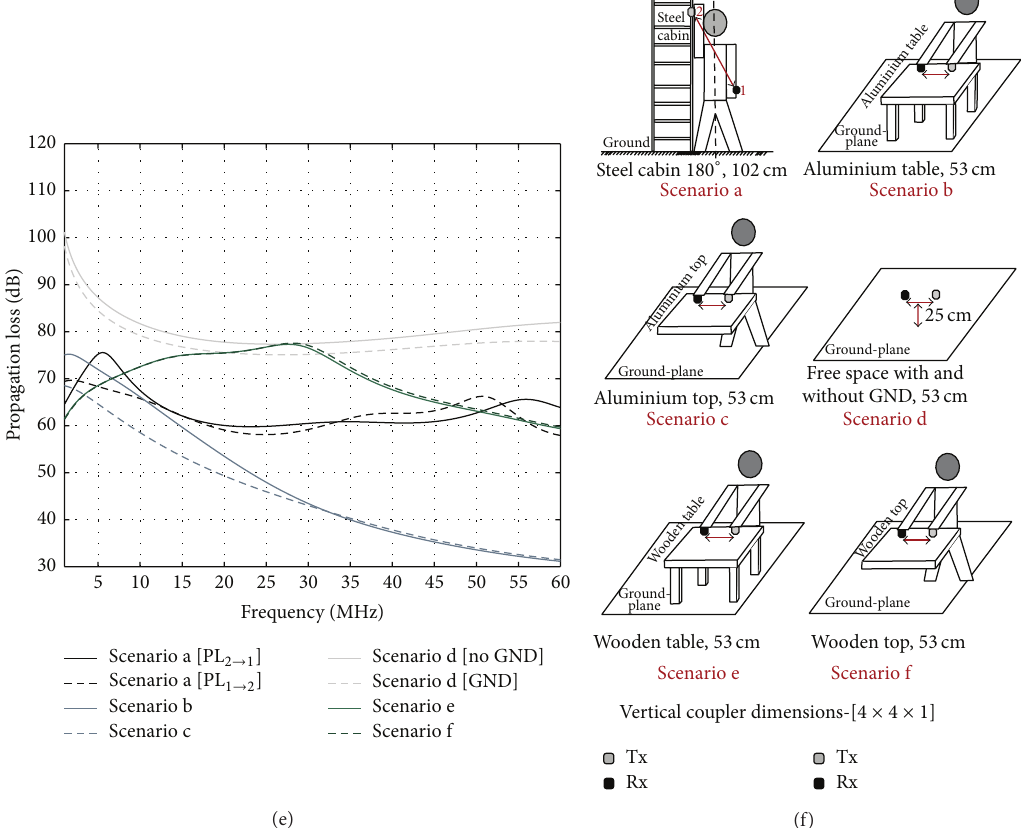
Figure 7: Plots for propagation loss (a), (c), and (e) with vertical coupler configuration for (b), (d), and (f) scenarios, respectively.